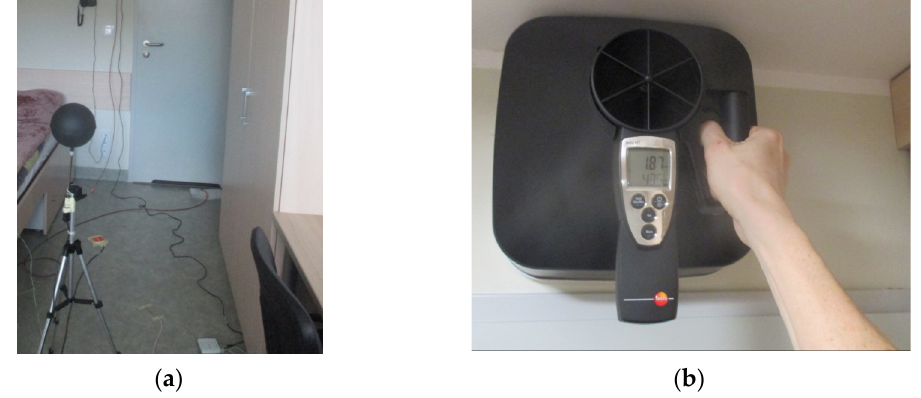
Figure 3. ( a ) View of the measurement equipment during assembling; ( b ) Measurement of ventilation air fl ow rate with Testo 417 anemometer.